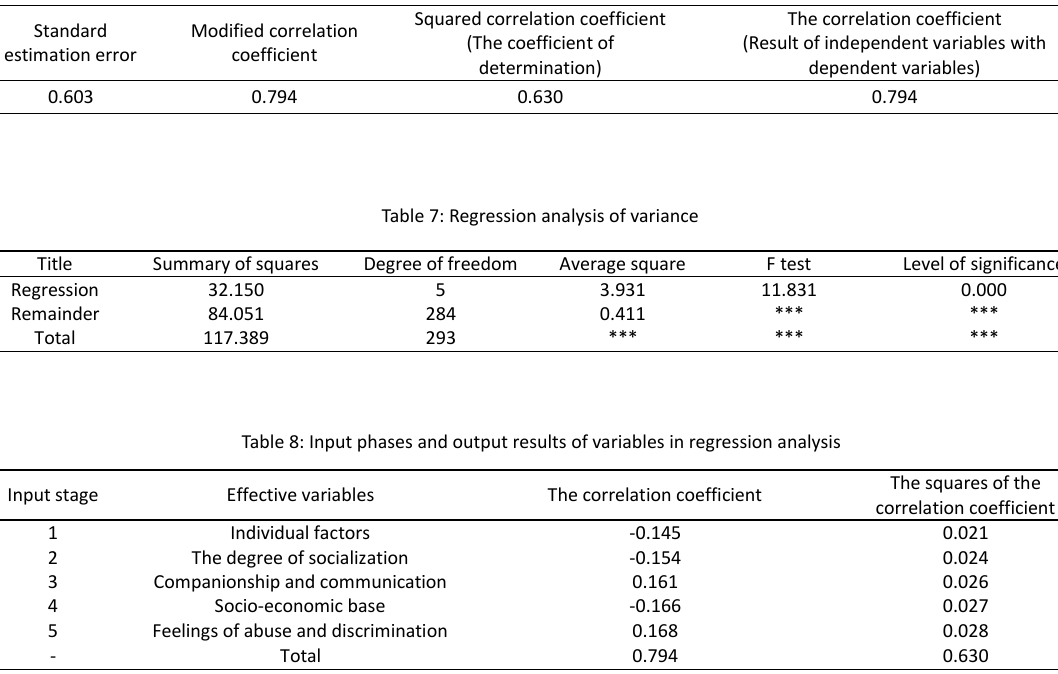
Table 6: Explanatory model of regression